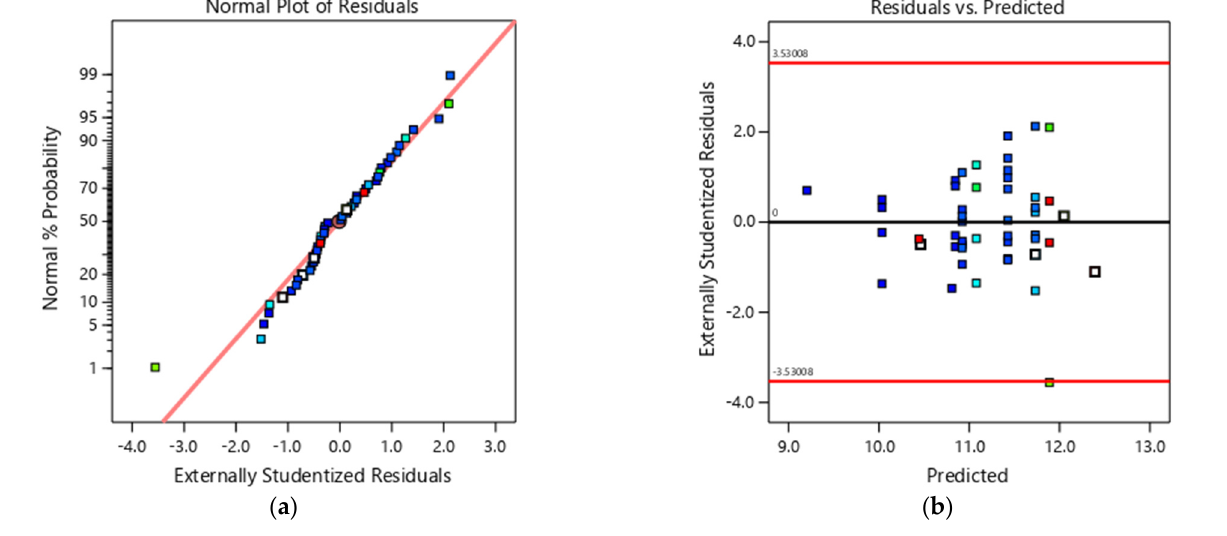
Figure 5. ( a ) Normal probability plot of the externally studentised residuals for the F,24 h fitted model, and ( b ) plot of the externally studentised residuals versus F,24 h fitted values.